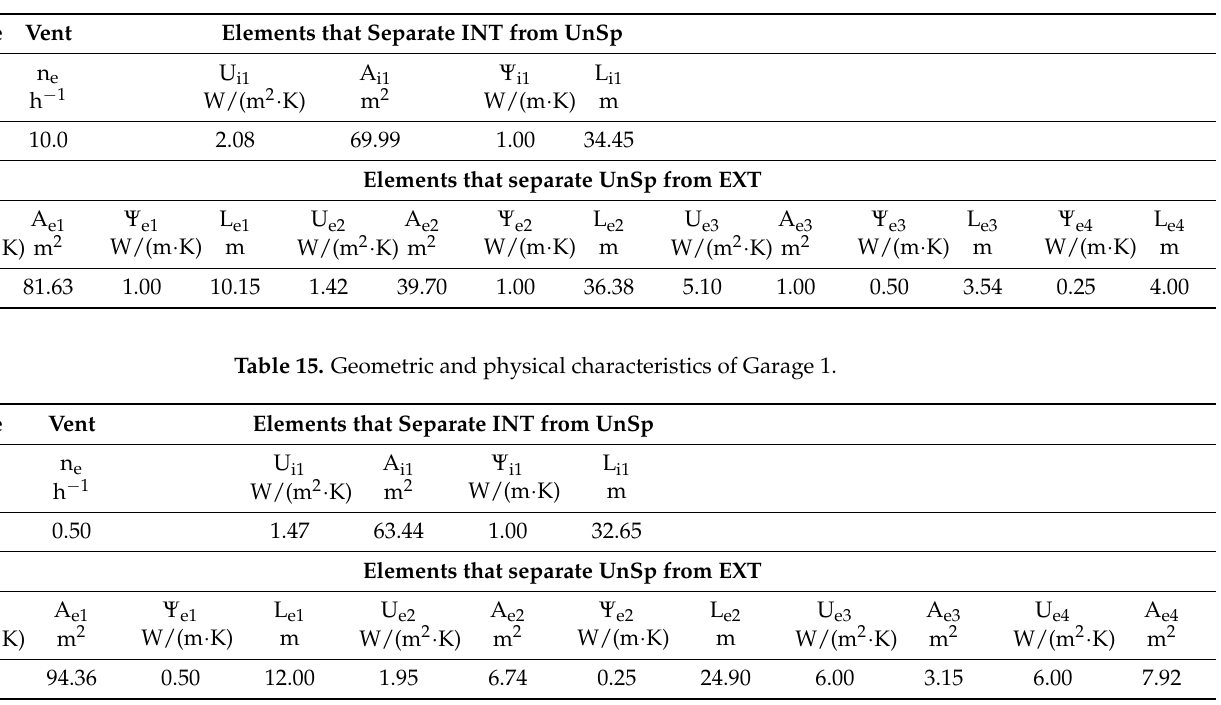
Table 14. Geometric and physical characteristics of Attic 2.